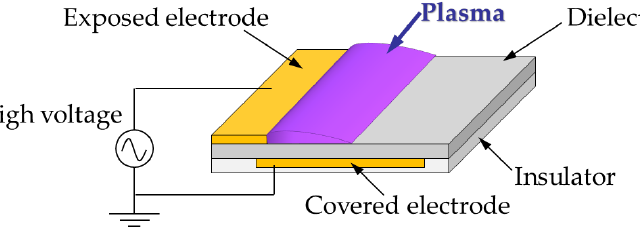
Figure 1. Typical configuration of a DBDPA.